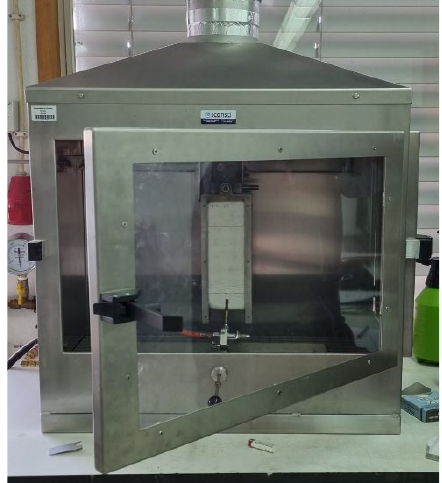
Figure 13. Fire ignitability test